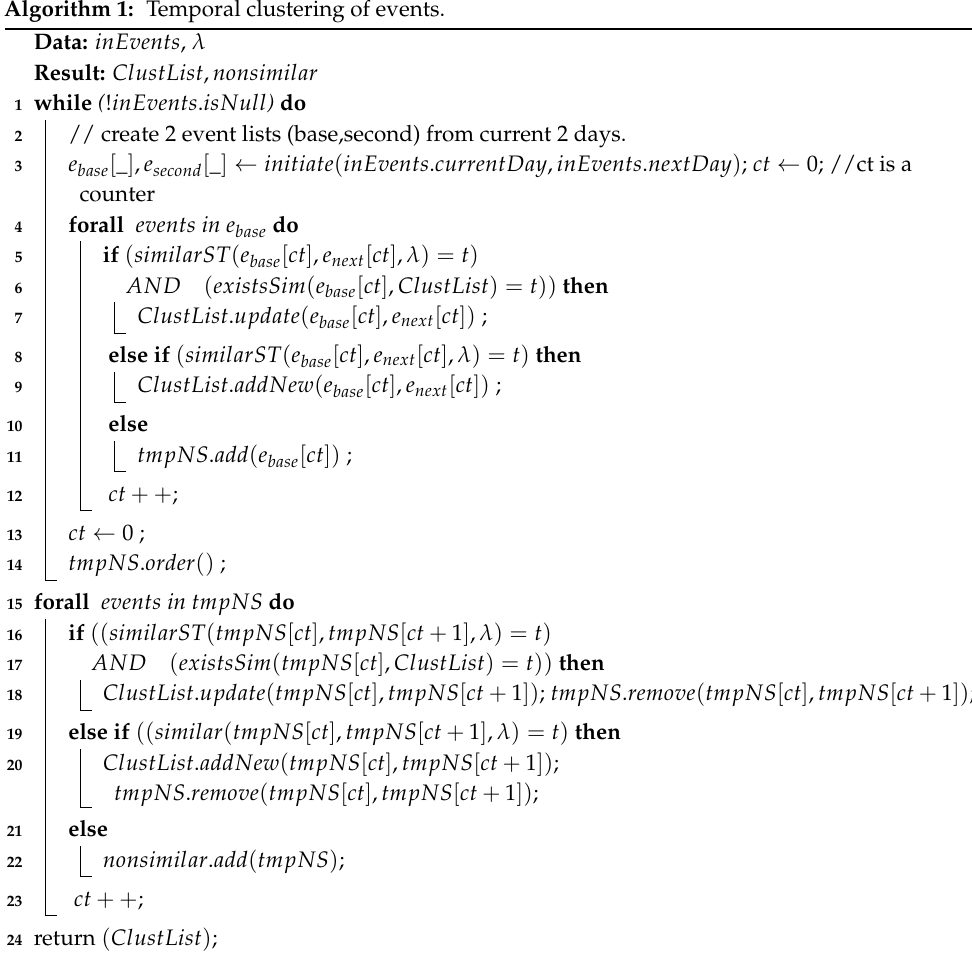
Algorithm 1: Temporal clustering of